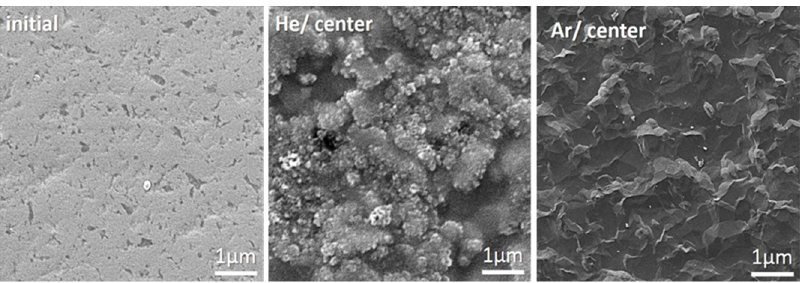
Figure 3. SEM images illustrating change of the initial W surface morphology by exposure to Hollow-Cathode discharges to He and Ar plasmas.